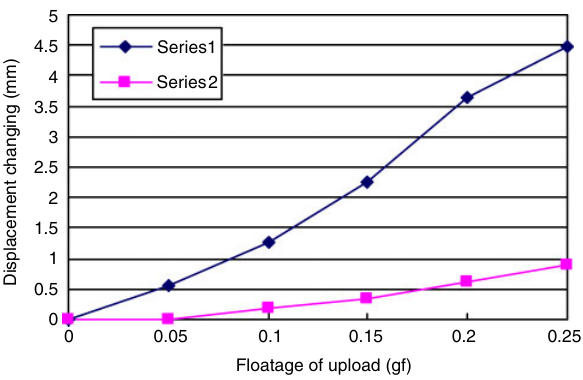
Figure 18 The flexibility of the static